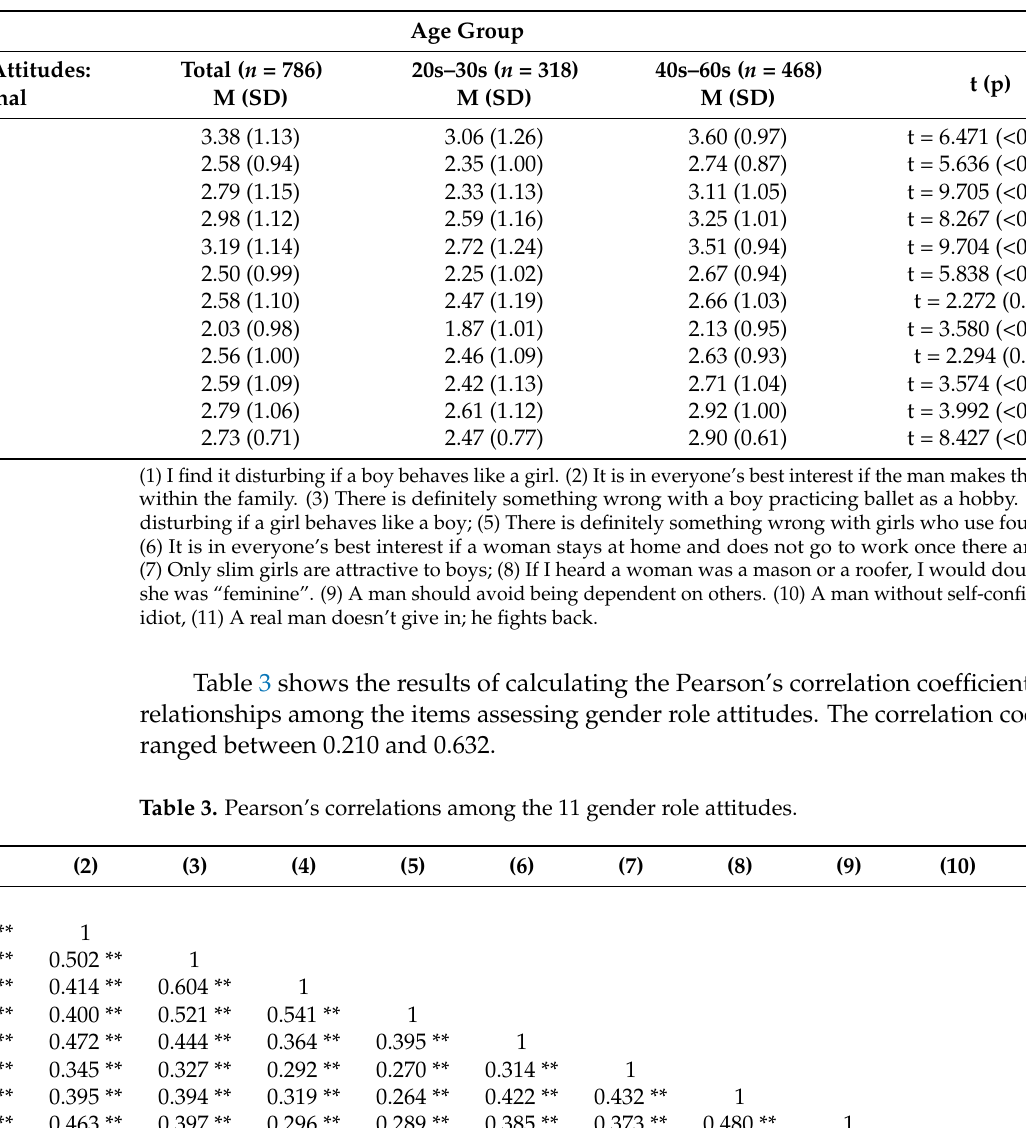
Table 2. Items and total scores across age groups for gender role attitudes.